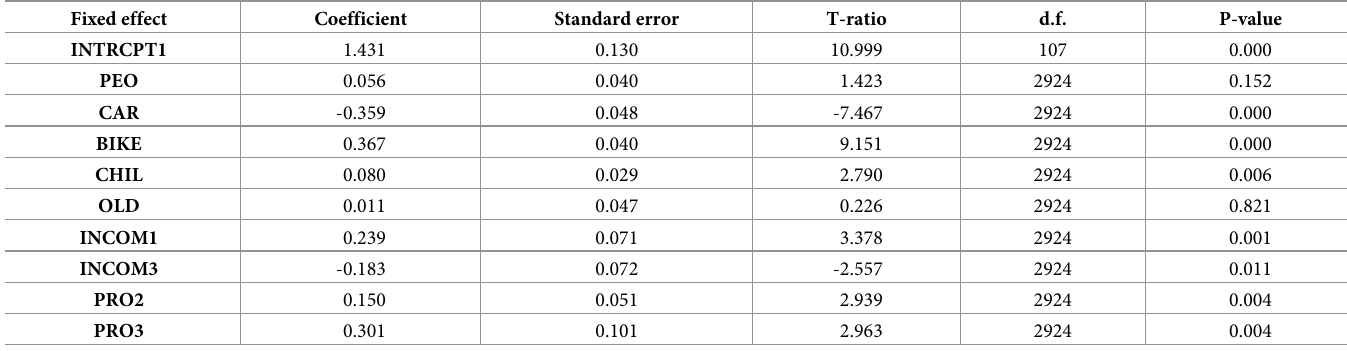
Table 3. The parameter estimation of the random coefficient regression